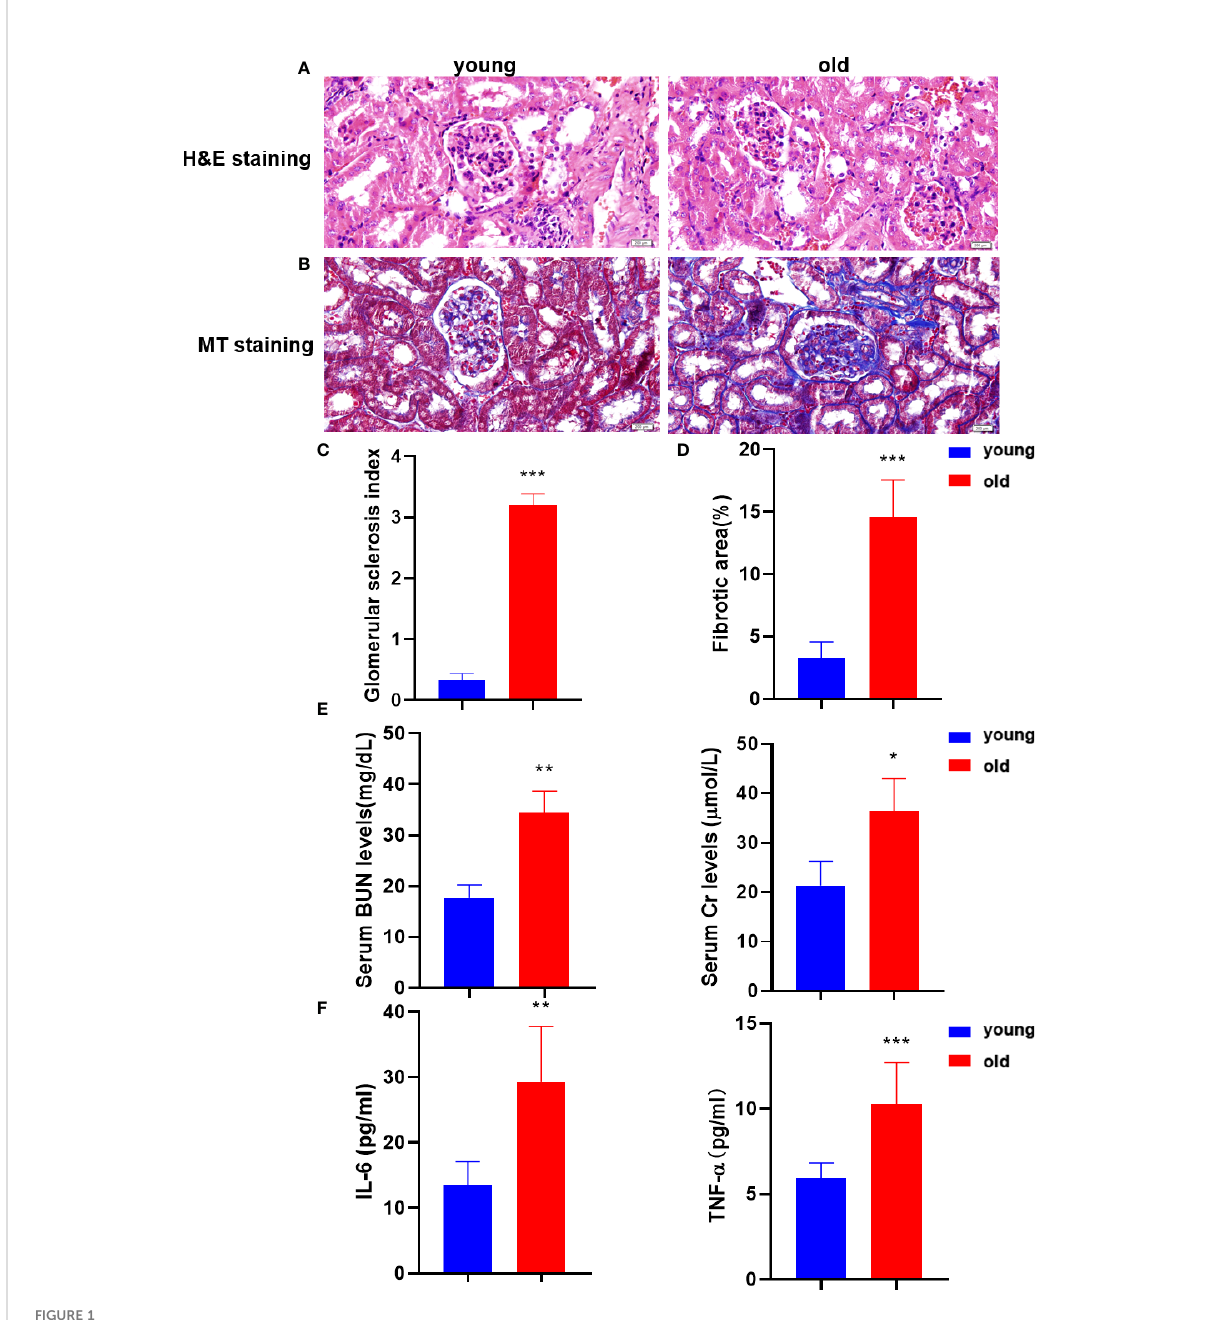
FIGURE 1 Aging kidneys were characterized by structural damage, pathological fi brosis, and dysfunction. (A) Histomorphological changes in the kidney were assessed using H&E staining (200 µm). (B) MT staining was performed to visualize kidney fi brosis (200 µm). (C) The glomerular sclerosis index in the two mice groups ( n = 6). (D) The positive rates of MT staining ( n = 6). (E) The levels of BUN and serum Cr were measured to verify kidney function. (F) The IL-6 and TNF- a levels were detected in serum using the enzyme-linked immunosorbent assay (ELISA) to evaluate the in fl ammatory damage. * p < 0.05, ** p < 0.01, *** p < 0.001 compared with the young